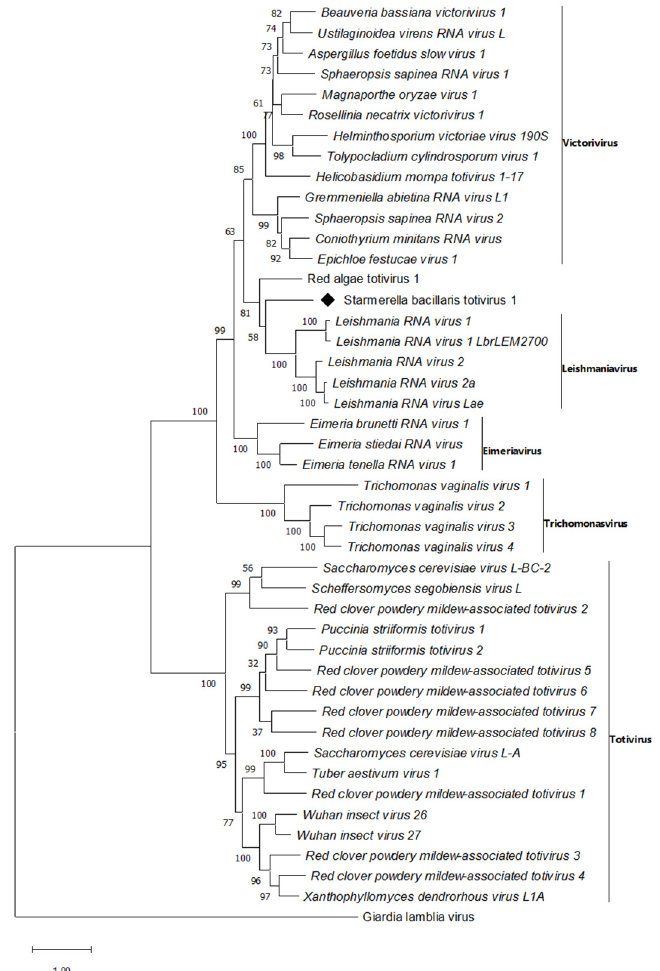
Figure 1. Phylogenetic analysis of Starmerella bacillaris totivirus 1 isolate Cz12 (SbTV1-Cz12). Maximum-likelihood tree was obtained following the alignment of RdRp amino acid sequences. Bootstrap values reported at the nodes are from 1000 replicates. The sequence determined in this work is indicated by ♦ .